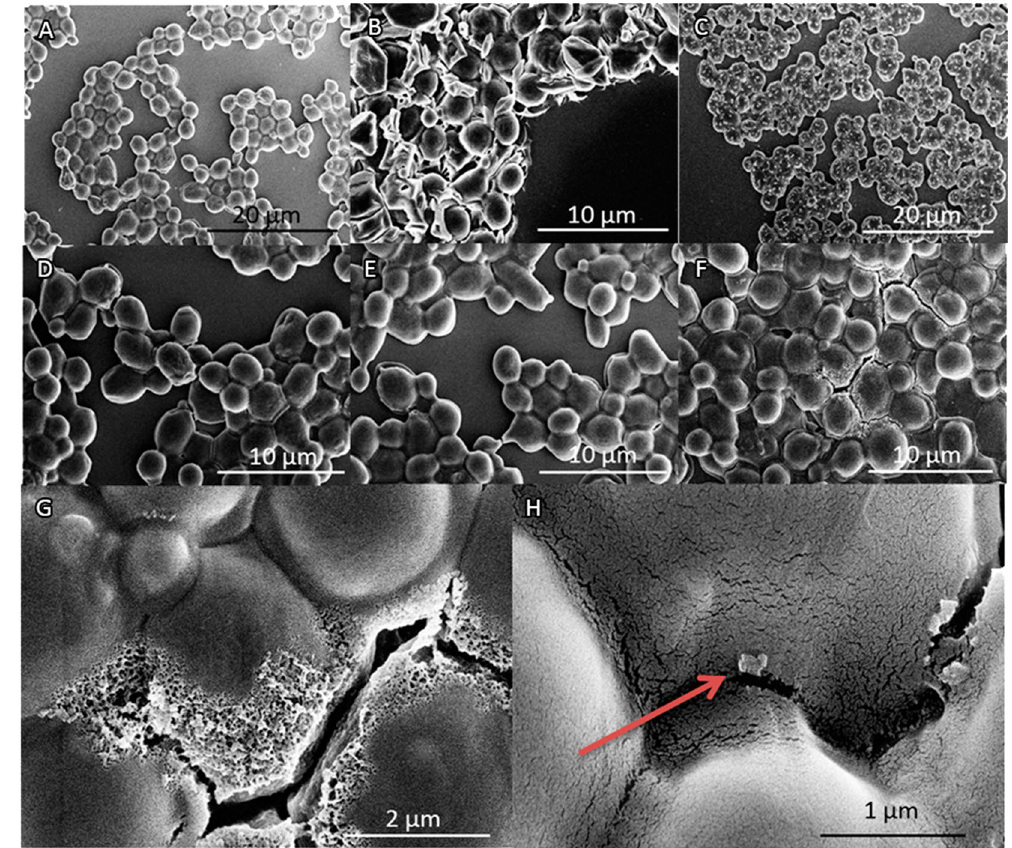
Figure 4. SEM visualizations of yeast cell topography and morphology. ( A ) Cells incubated with FNDs. ( B ) Cells after treatment with 2% DMSO and TMIX. Distorted cell morphology shows the side effects of this technique. ( C ) Cells treated with 0.1% Triton and FNDs: an accumulation of salts due to drying on the outside of the cells can be seen in white. ( D ) Cells treated with 0.1% Triton, TMIX and FNDs. ( E ) Cells electroporated with 1 pulse. Some light cellular damage can be observed. ( F ) Cells electroporated with 8 pulses. The cell wall of these cells is severely damaged as a result of the applied high electrical currents. ( G ) Disintegration of the cell wall results in puncturing and will lead to cell death (close up of F). ( H ) Close up of a diamond particle on the outside of a cell (indicated by the arrow, close up of